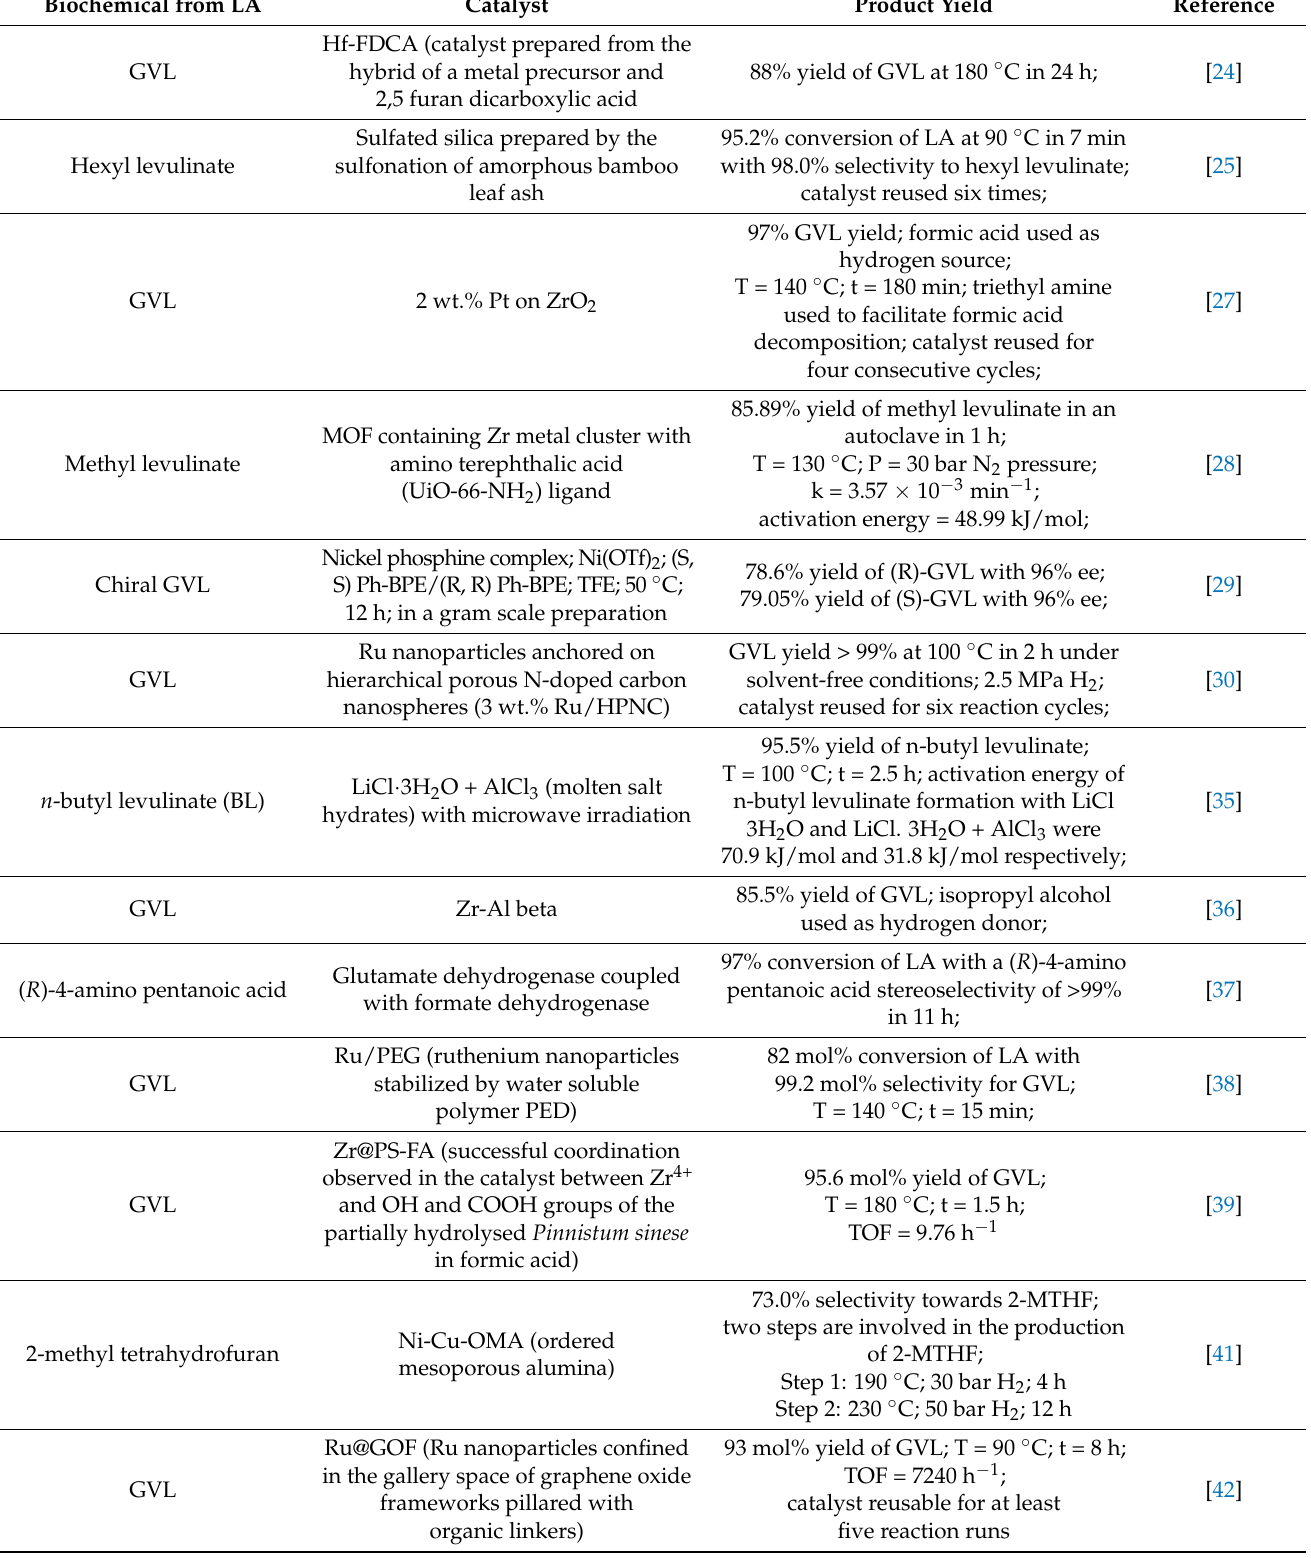
Table 2. Biochemicals from levulinic acid